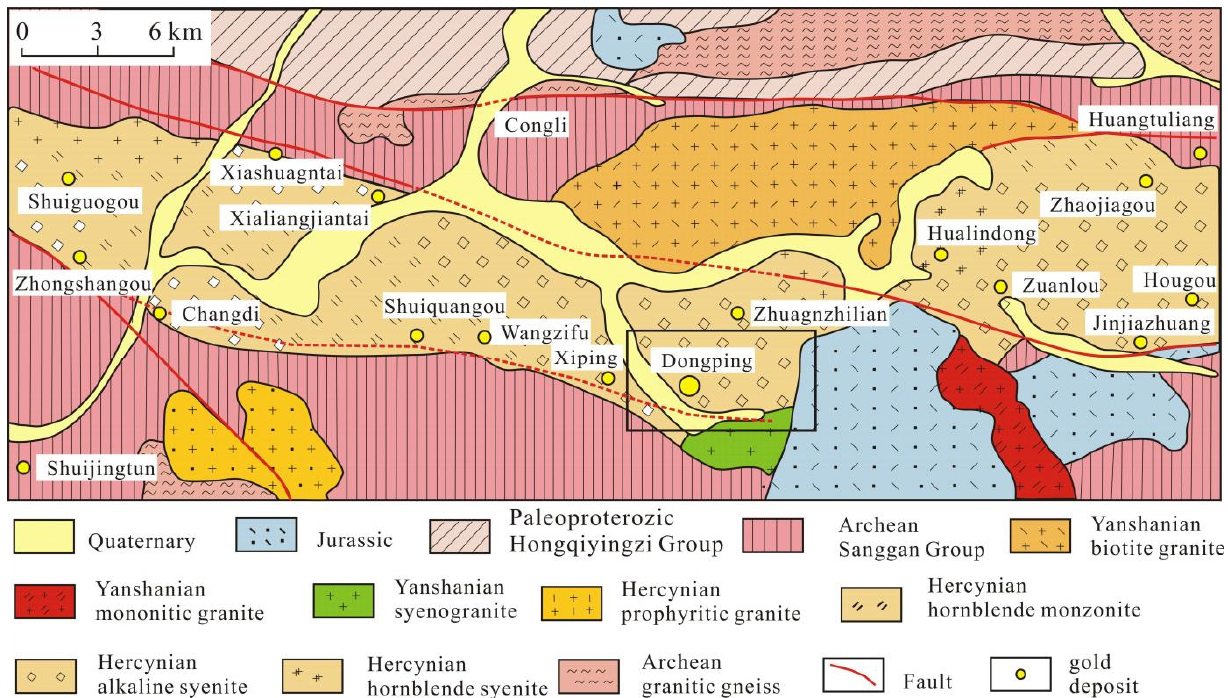
Figure 2. Geological sketch map of the area surrounding the Dongping gold deposit in the Hebei province (modified after Song and Zhao [17]; Li et al.